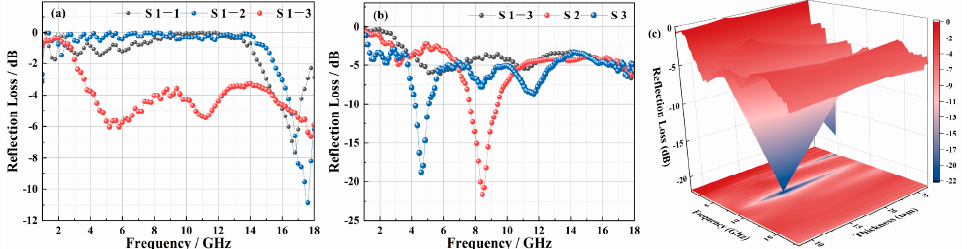
Figure 6. ( a ) The reflection loss of S1-1, S1-2, and S1-3; ( b , c ) the reflection loss of the different-layer 3D GHWCs with triangular sections.